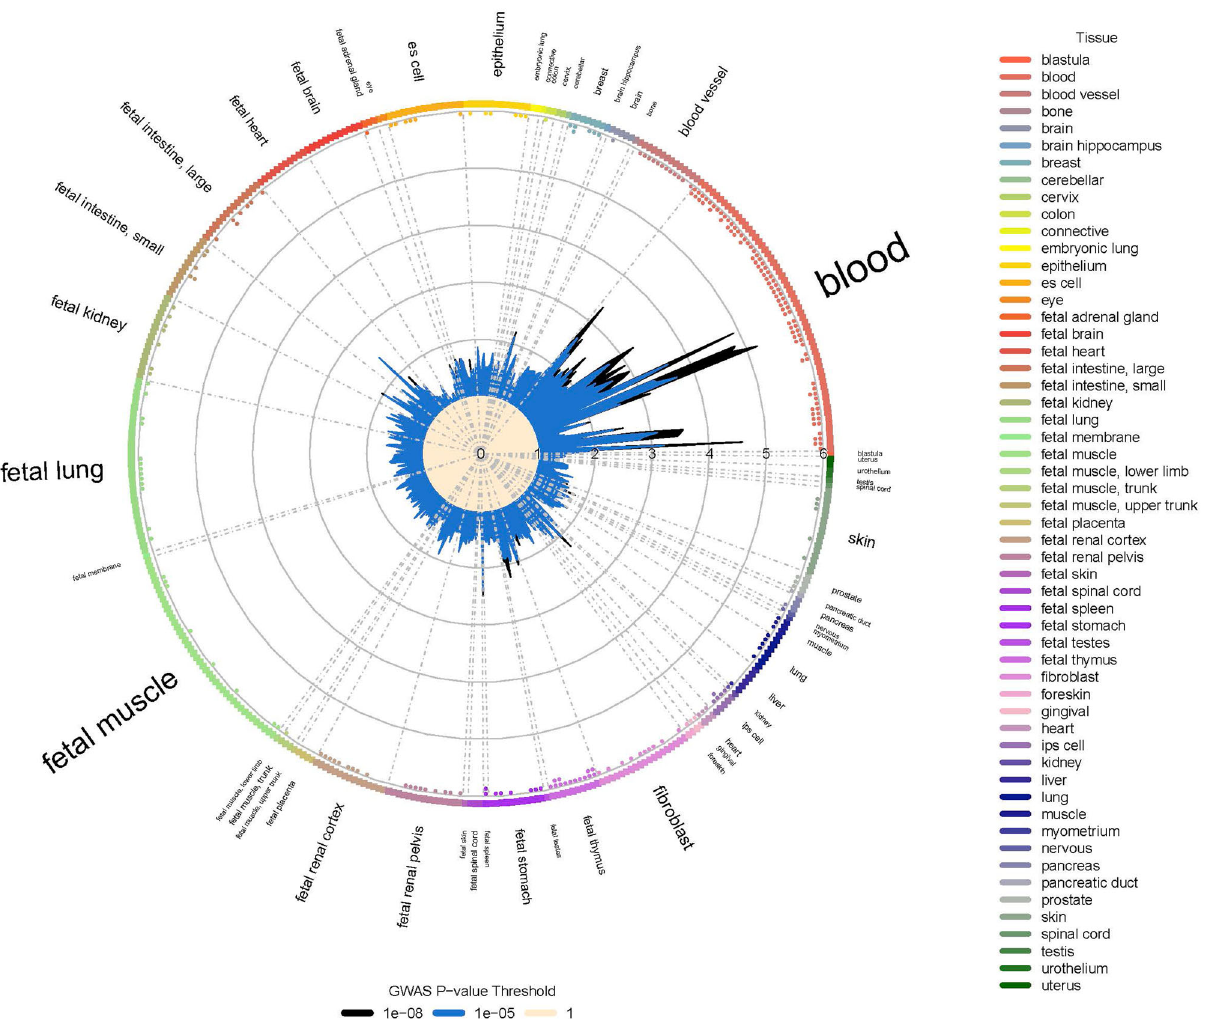
Fig. 5 GARFIELD functional enrichment analyses. The wheel plot shows functional enrichment for asthma variants within DNase I hypersensitivity site hotspot regions in ENCODE and Roadmap Epigenomics data. The radial axis represents the enrichment (OR) for each of 424 cell types that are sorted by tissue along the outside edge of the plot. Tissues are labeled with font size proportional to the number of cell types. Boxes forming the edge are colored by tissue. Enrichment is calculated for two GWAS signi fi cance thresholds: 1.0E − 5 and 1.0E − 8, which are plotted in blue and black, respectively, inside the plot. Dots along the inside edge of the plot are colored with respect to tissue and represent signi fi cant enrichment for a speci fi c cell type (one dot = P < 1E − 5 and two dots = P < 1E −